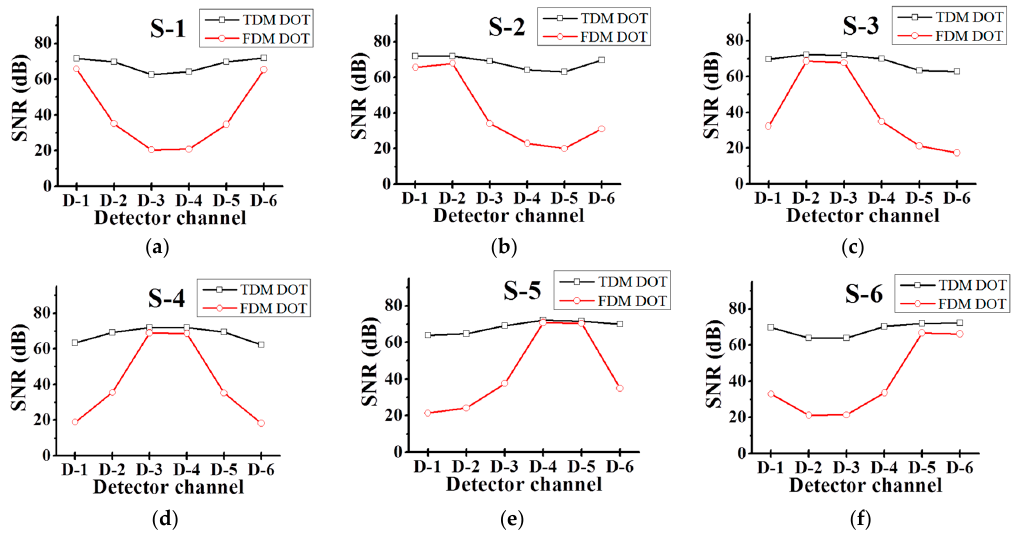
Figure 3. Graphs of signal to noise ratio (SNR) versus S-D pairs at ( a ) Source 1, ( b ) Source 2, ( c ) Source 3, ( d ) Source 4, ( e ) Source 5, and ( f ) Source 6. The black and red solid lines with circles represent the TDM DOT and FDM DOT systems, respectively.